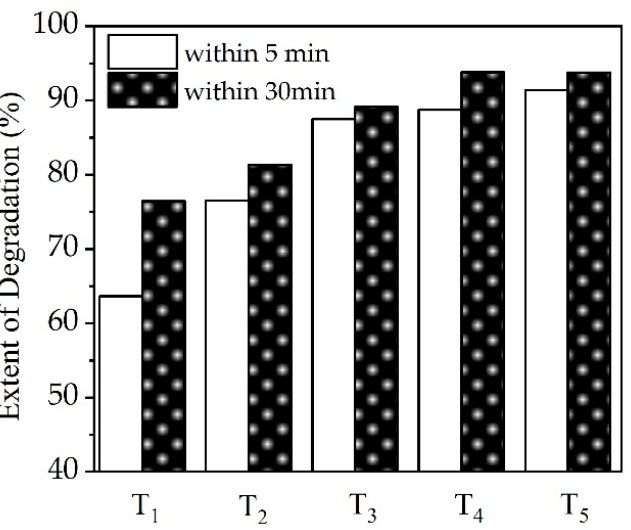
Figure 4. Effect of H 2 O 2 on extent of degradation of CTC for the combination of HC with H 2 O 2 at 5 min and 30 min. T1: HC + 0.5 mM H 2 O 2 , T2: HC + 1.0 mM H 2 O 2 , T3: HC + 2.0 mM H 2 O 2 , T4: HC + 4.0 mM H 2 O 2 , T5: HC + 8.0 mM H 2 O 2 .